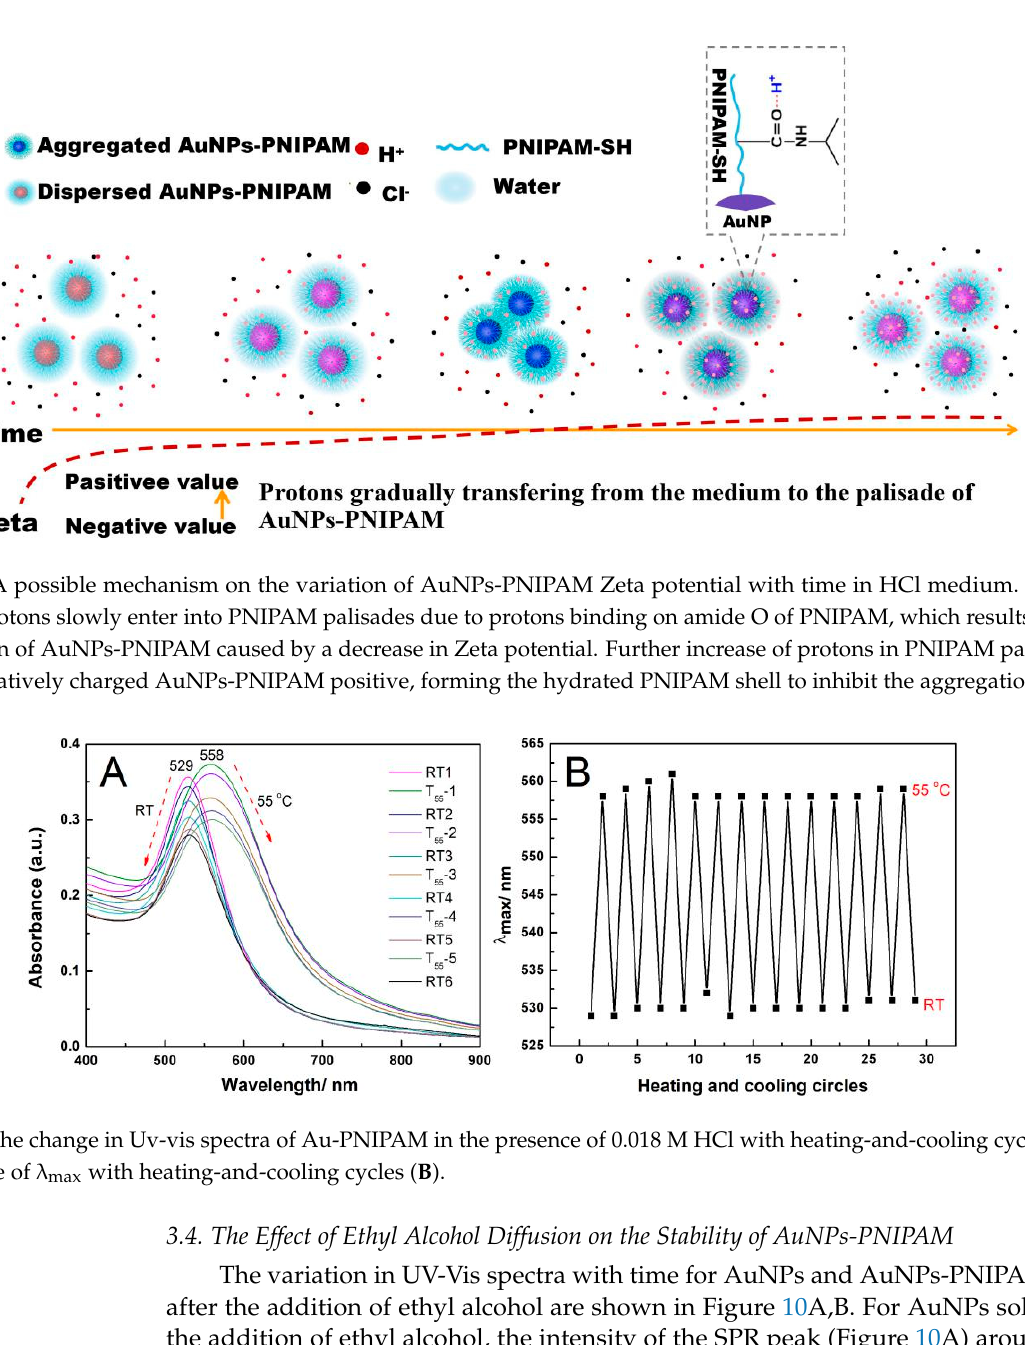
Figure 8. A possible mechanism on the variation of AuNPs-PNIPAM Zeta potential with time in HCl medium. In this process, protons slowly enter into PNIPAM palisades due to protons binding on amide O of PNIPAM, which results in the aggregation of AuNPs-PNIPAM caused by a decrease in Zeta potential. Further increase of protons in PNIPAM pali- sades makes negatively charged AuNPs-PNIPAM positive, forming the hydrated PNIPAM shell to inhibit the aggrega- tion.